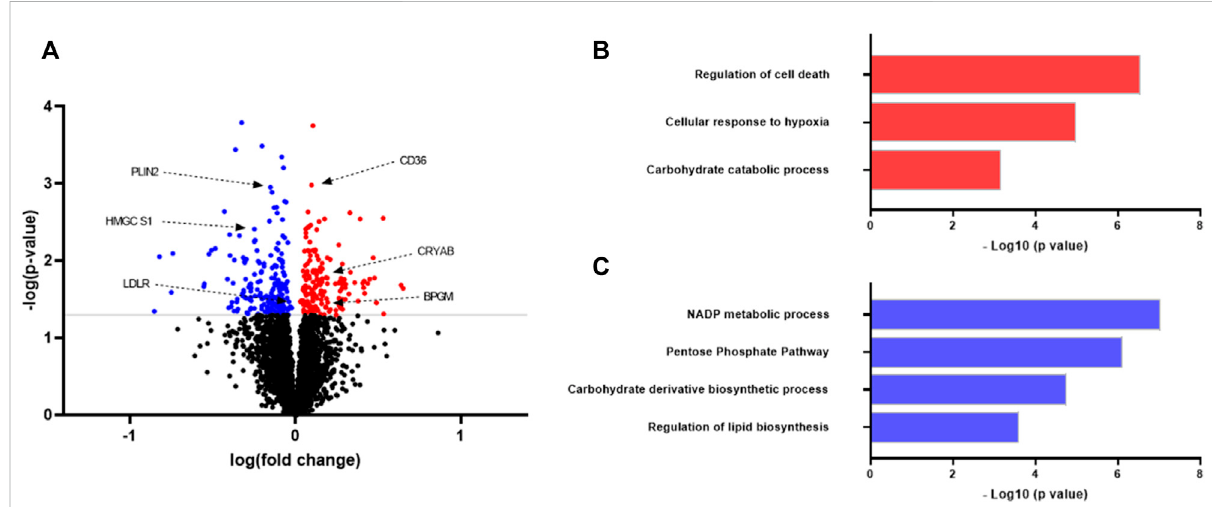
FIGURE 1 Proteomic analysis of protein expression in myotubes from lean donors and donors with obesity. Human myoblasts were grown and differentiated to myotubes in 25 cm 2 cell culture fl asks. On day 7 of differentiation the myotubes from eight different donors in each group were harvested for proteomic analysis. Lean group was considered as a control for the comparison. (A) Volcano plot of differentially regulated proteins. Someproteinsmentionedinthetextareshown.Statisticalsigni fi cancewascalculatedasthedifferencebetweenthetwogroupsusingunpaired t test,andthesedifferenceswereconsideredsigni fi cantif p < 0.05. (B) Upregulatedbiologicalprocessesinmyotubesfromindividualswithobesityas compared to lean. (C) Downregulated biological processes in myotubes from individuals with obesity as compared to lean. Results from gene ontology (biological processes) analysis performed using STRING software (https://string-db.org/). Selected differently regulated pathways related to metabolism and signaling. CD36, cluster of differentiation 36; PLIN2, perilipin two; BPGM, biphosphoglycerate mutase; LDLR,